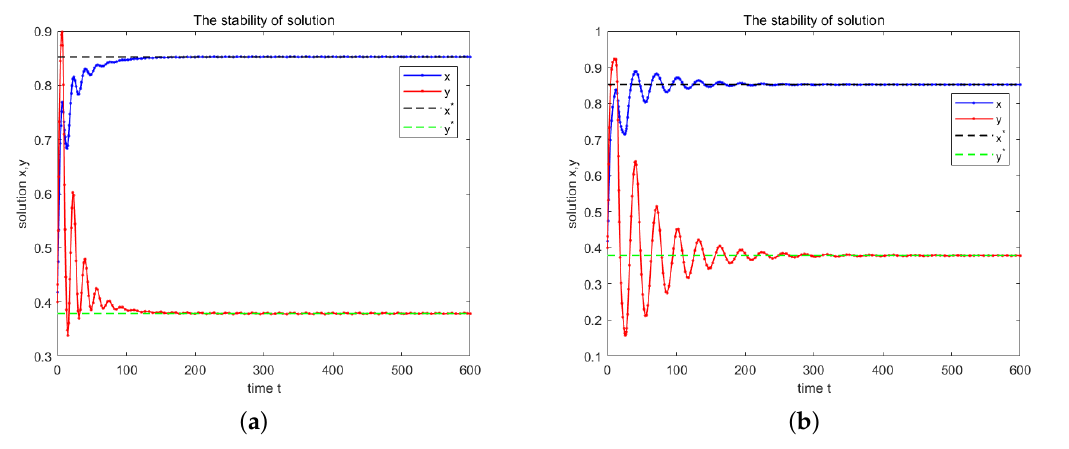
Figure 2. ( a ) The stability of the mixed ESS when τ 1 = 6, τ 2 = 7 time units. ( b ) The instability of the mixed ESS when τ 1 = 12, τ 2 = 14 time units, where p 0 = 0.6, p 1 = 0.2, p 2 = 0.2 and q 0 = 0.5, q 1 = 0.4, q 2 =